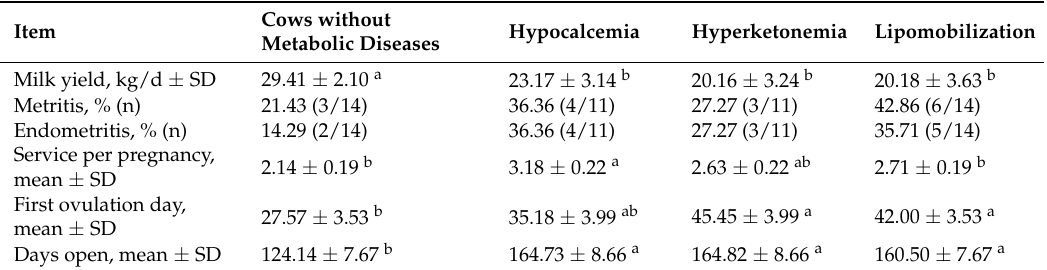
Table 1. Effect of metabolic disease during peripartum on milk yield, prevalence of metritis and endometritis, and service per pregnancy, day of first ovulation and days